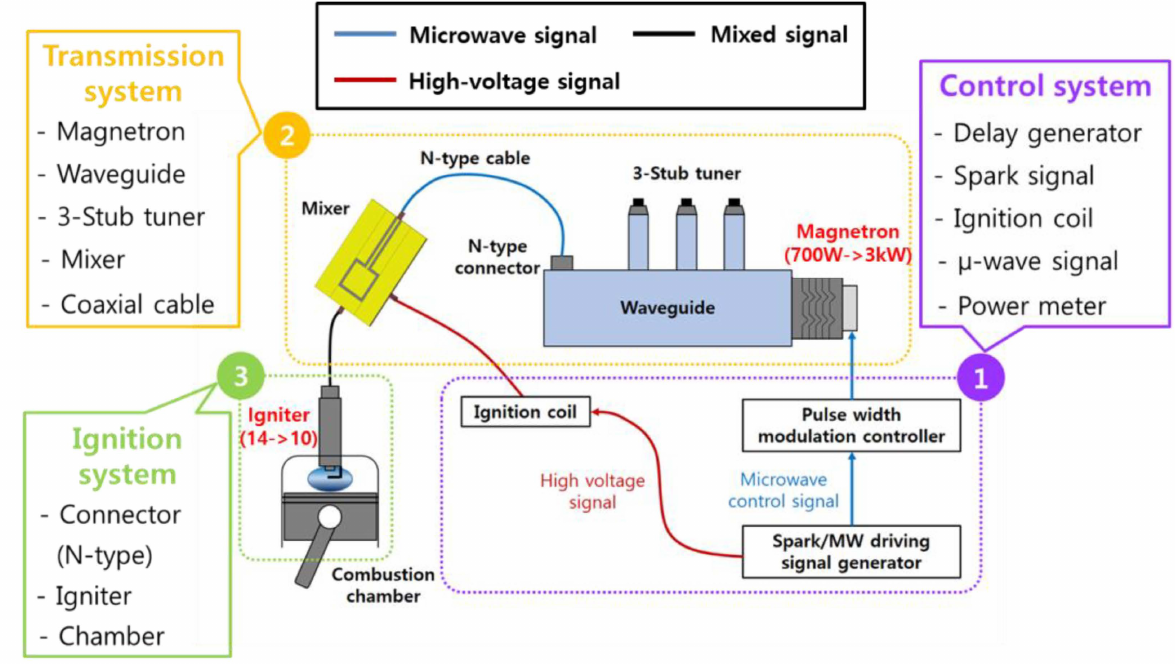
Figure 11. Schematic of the microwave-assisted plasma ignition